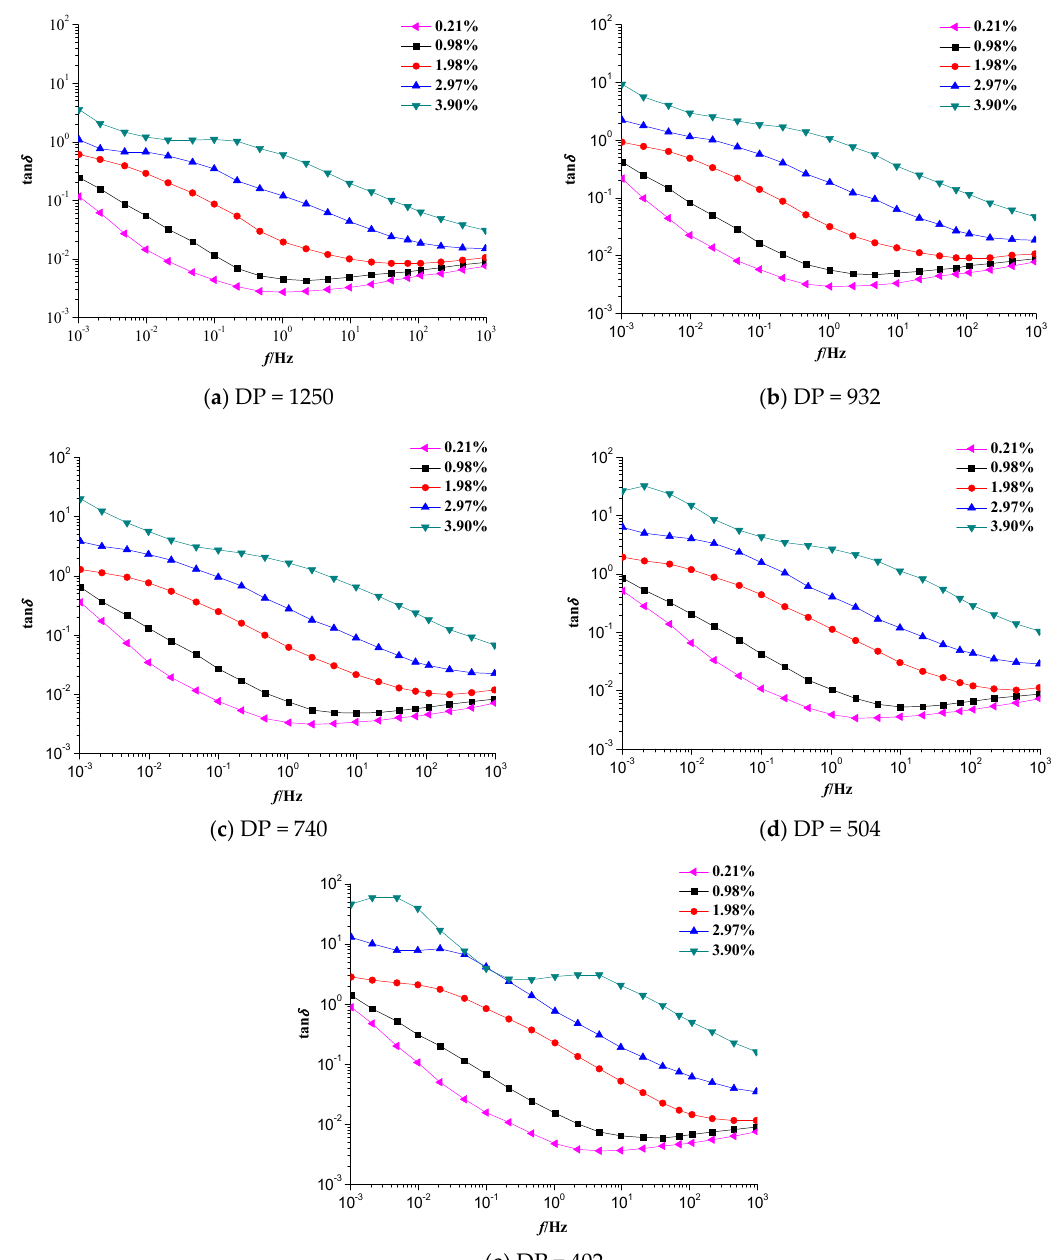
Figure 3. The tan δ curve of samples under different moisture content in set A~E.